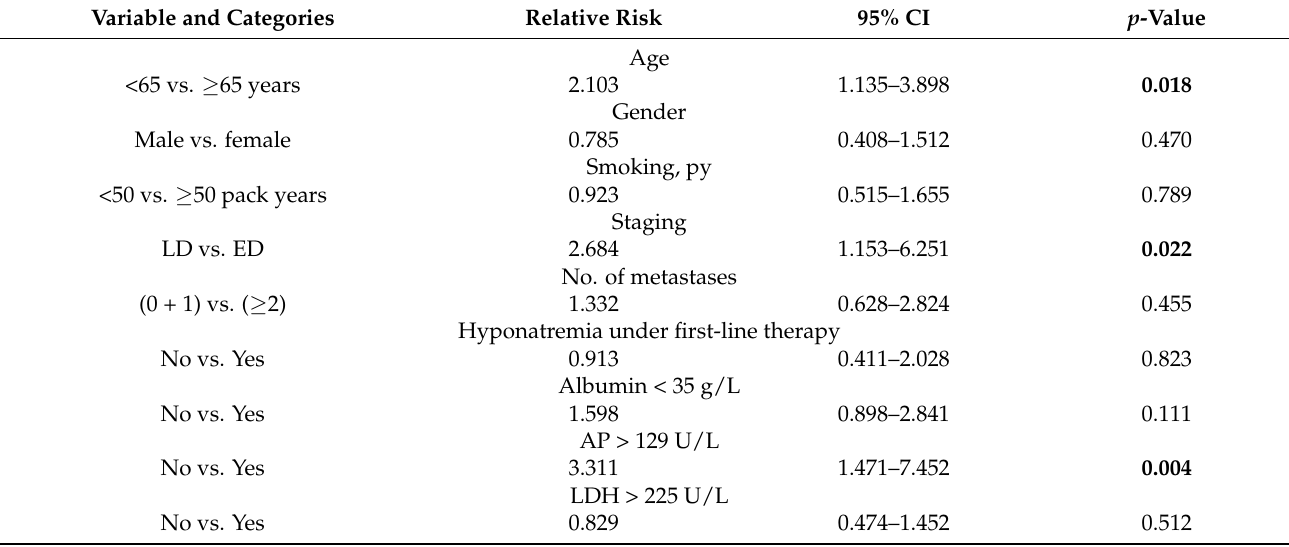
Table 8. Multivariate